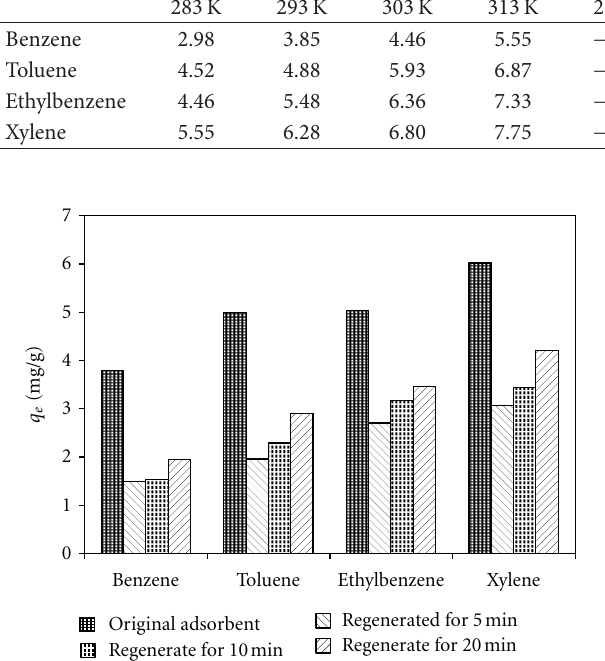
F 5: Effect of temperature of 150